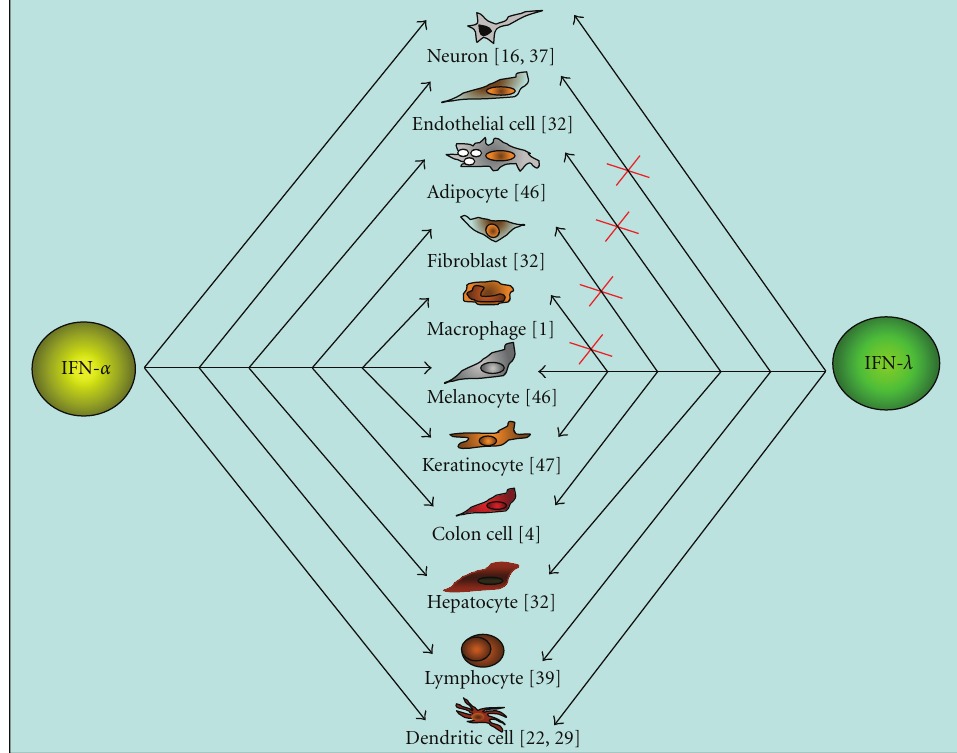
Figure 2: Cellular targets for type I and type III IFNs. Response to IFN- α and IFN- λ in cells from di ff erent origins in human. The IFN response was assessed by measuring the IFN-induced cell signaling (Stat activation) and cell activity (MHC class I antigen stimulation). In contrast to IFN- α , only restricted cells respond to IFN- λ , including epithelial-like cells, forming the major organs of the body.